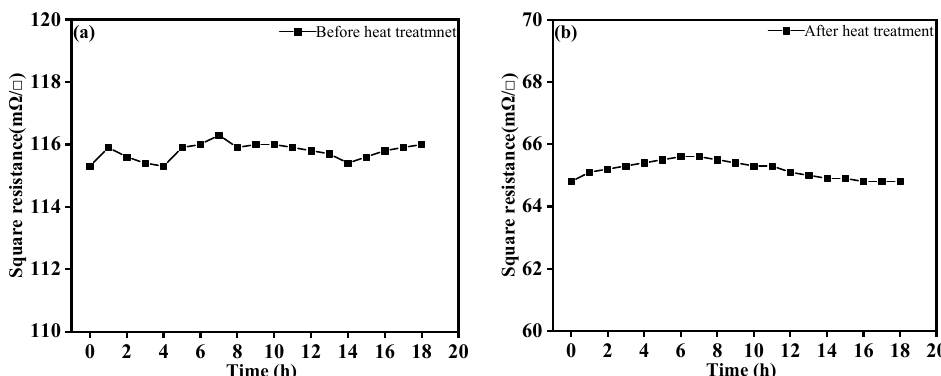
Figure 7. ( a ) Variation of square resistance of Ag layers with time at 30 °C before heat treatment ( b ) Variation of square resistance of Ag layers with time at 30 °C after heat treatment.